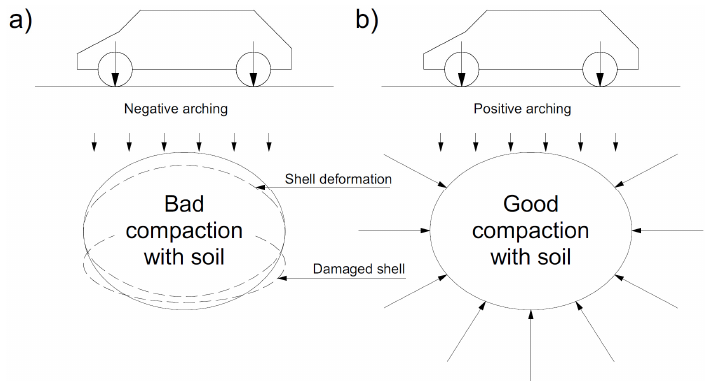
Figure 2. Idea of soil–steel bridge with arching phenomenon: ( a ) negative and ( b ) positive. In the case of dynamic loads, the main goal of each paper was to perform the dynamic identification of these structures (modal analysis) and their response to variable loads (due to vehicle traffic) [17,23–34]. In addition, the dynamic loads, which are difficult to predict due to their random characteristics, should also be taken into account. Such dynamic loads include seismic loads caused by an earthquake or anthropogenic loads caused by human activity, e.g., mining tremors. So far, the finite element method has been used in the analysis of the impact of seismic tremors on underground soil–steel composite structures. As part of the numerical tests, the influence of the soil cover height above the steel shell [35], the influence of stiffening elements [36], and the influence of the EPS layer damping seismic and anthropogenic excitation [37] were determined. In addition, research works [38] and [39] attempted to determine the impact of seismic shocks based on the observed damage caused by seismic excitation. It was noted in works [40–42] that the impact of seismic tremors on soil–steel objects is significant, and numerical analysis can be used to assess their behaviour under seismic inputs. The main aim of the study was to establish a reply to the following question: what influence does seismic excitation have on the safety of soil–steel composite bridges under given boundary conditions? The paper reports the results of numerical analysis of soil– steel bridges subjected to strong seismic loading for various designs of bridge cross- section. Therefore, two soil–steel bridges were used in the study. The numerical program DIANA FEA was used for the numerical analysis. The seismic record from the El Centro earthquake was applied as the source of strong seismic excitation. The conducted research will be helpful in designing this type of object located in seismic areas. 2. Methodology 2.1. Description of the Real Bridges Two soil–steel bridges made of corrugated sheets were analysed in this paper. The tested objects are located in Poland, where there are no significant natural seismic phenomena. On the other hand, in Poland there are human induced seismic events, i.e., mining tremors, which are similar to earthquakes, but their strength is smaller. In addition, analyses of soil–steel bridges and culverts under seismic load are relevant for countries where seismic phenomena occur frequently, and the conclusions of this work can be used to assess the behaviour of this type of bridge. In order to assess the seismic behaviour of soil–steel composite bridge with various structural reinforcements (RC collars, RC front walls), two different types of such bridges were selected. The first bridge has an open steel shell structure founded on the RC footings, and the second one has a closed profile founded directly on the ground. It should be mentioned that both bridges were previously tested under static [12] and dynamic